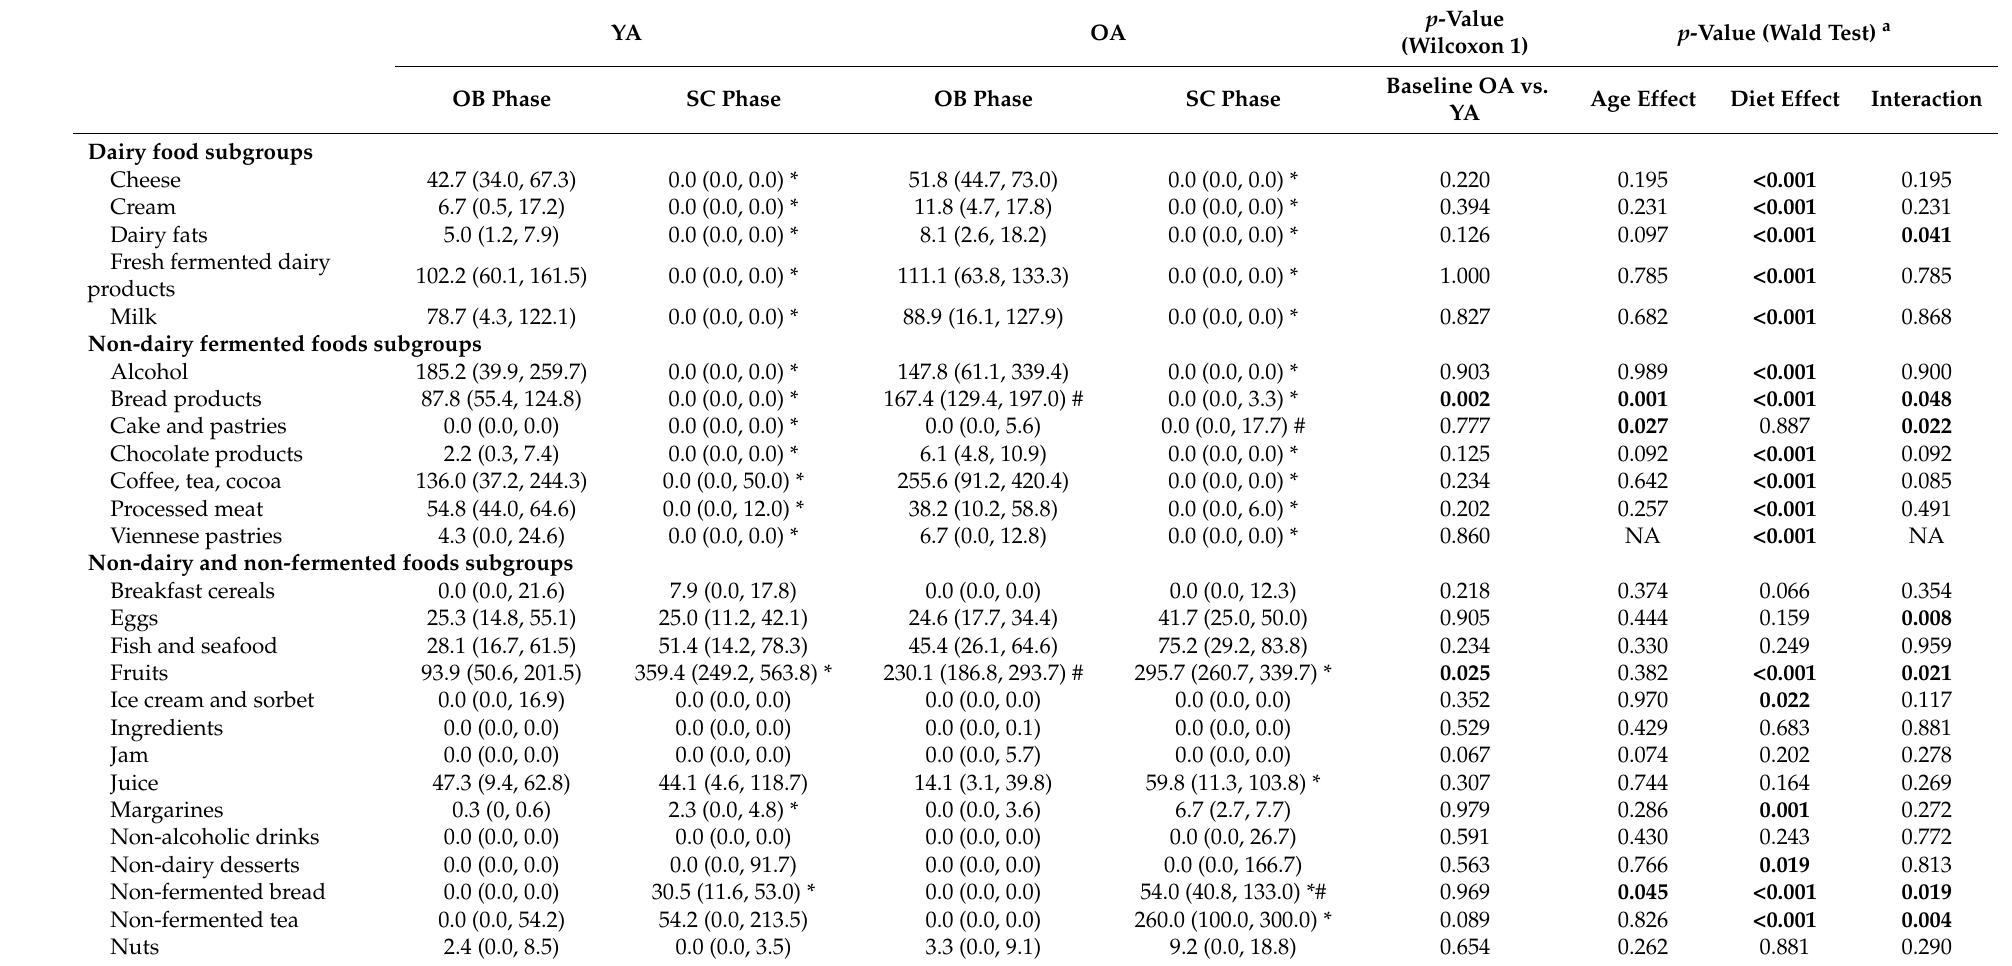
Table 1. Food subgroup intakes (median (IQR); g/d) during observation and semi-controlled phase in young and older men (foods consumed by at least 25% of